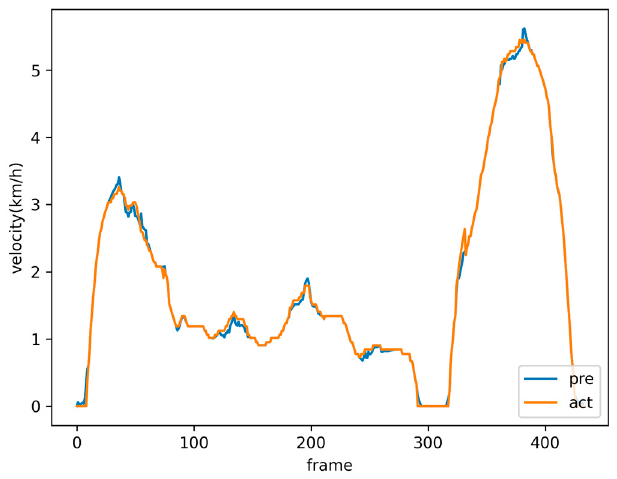
Figure 13. Vehicle speed curve predicted by CNN-LSTM model.